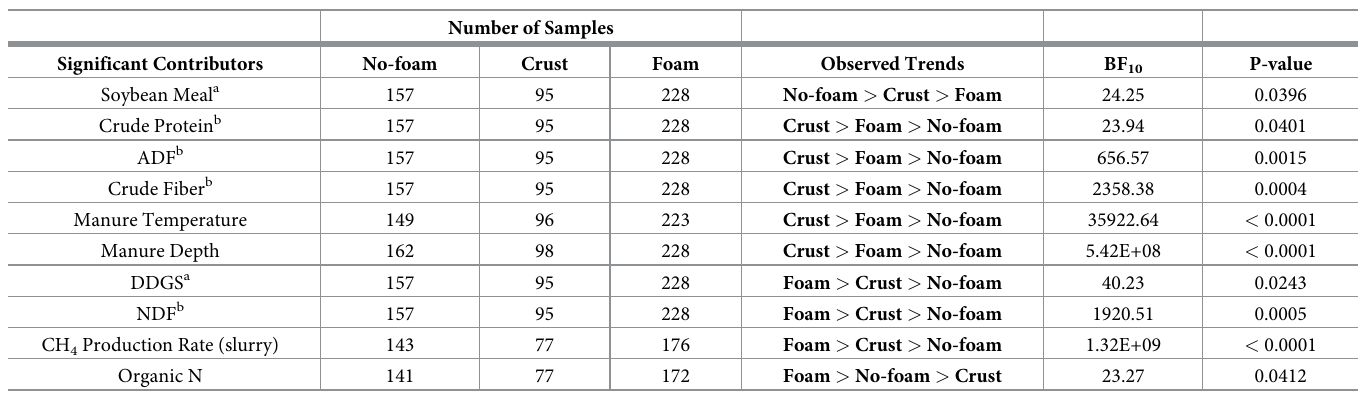
Table 1. Diet and manure characteristics in manures with different surface